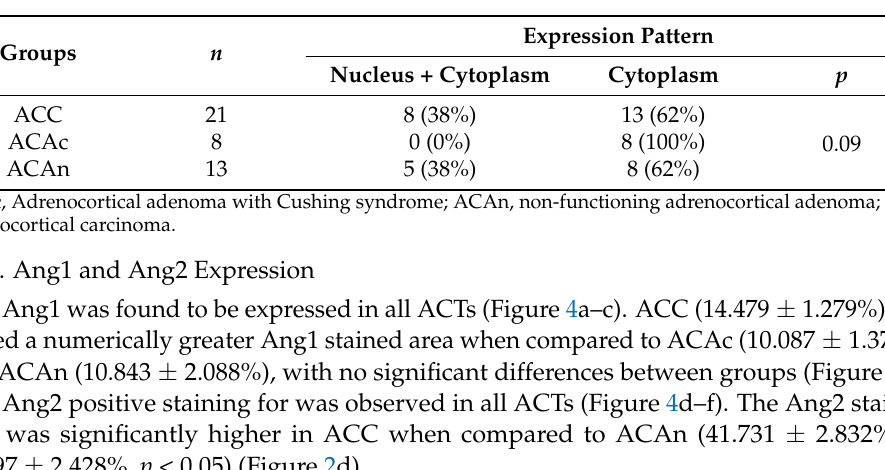
Figure 3. Immunochemistry staining of adrenocortical carcinoma (ACC), adrenocortical adenoma with Cushing syndrome (ACAc) and non-functioning adrenocortical adenoma (ACAn) for VEGF (20 µm) ( a – c ) and VEGF-R2 (20 µm) ( d – f ). Different VEGF immunochemistry patterns presenting cytoplasm staining ( a – c ); VEGF-R2 nuclear staining in ACC, ACAc and ACAn ( d – f ). Table 1. VEGF immunostaining localization in the different groups of adrenocortical